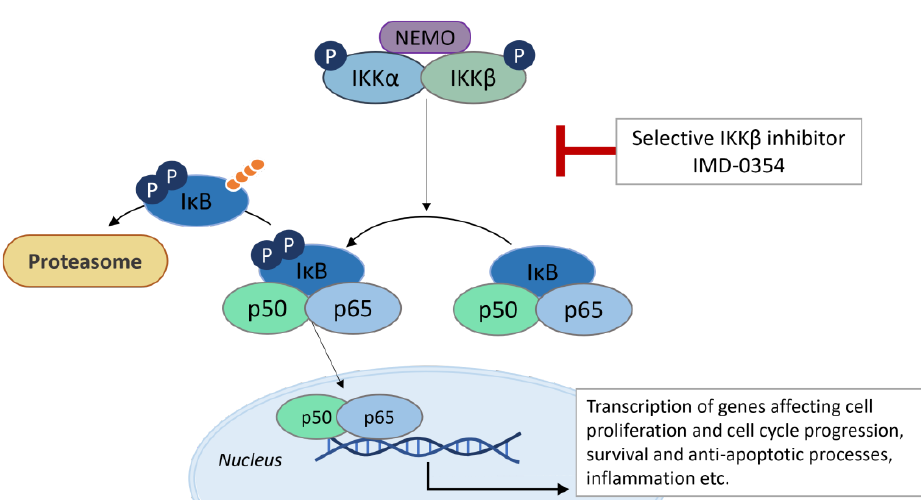
Figure 6. Canonical NF- κB pathway as possible target of selective inhibitor of IKKβ IMD -0354. Upon wide variety of activating stimuli, trimeric complex that consists of catalytic subunits, IKKα and IKKβ, and a regulatory subunit NEMO could phosphorylate two serine residues of IκB bound to NF- κB dimers. NF - κB occurs mainly in the form of p50/p65 dimers. This phosphorylation leads to ubiquitination of I κ B and its proteasome degradation. Thus NF- κ B is translocated into the nucleus and modulates gene transcription. Scheme was created according to [133,137,138] .